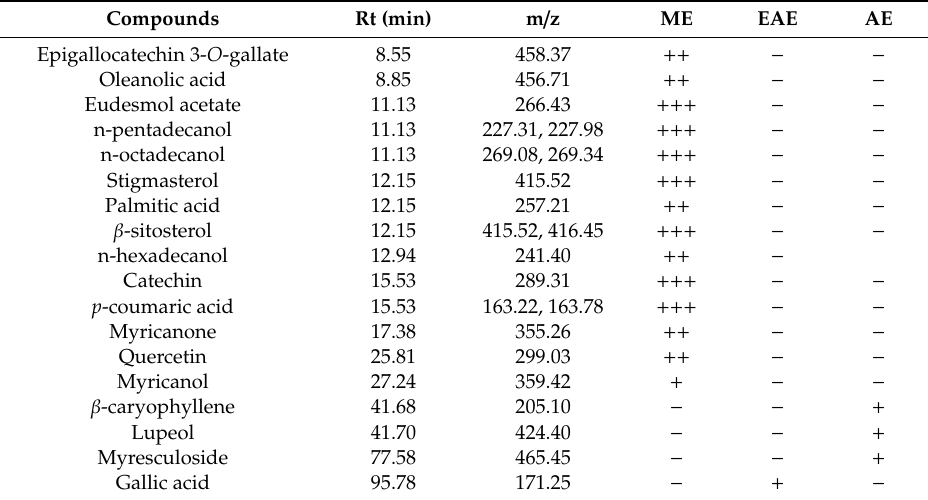
Table 5. LC-MS analysis of M. esculenta leaves extracts.